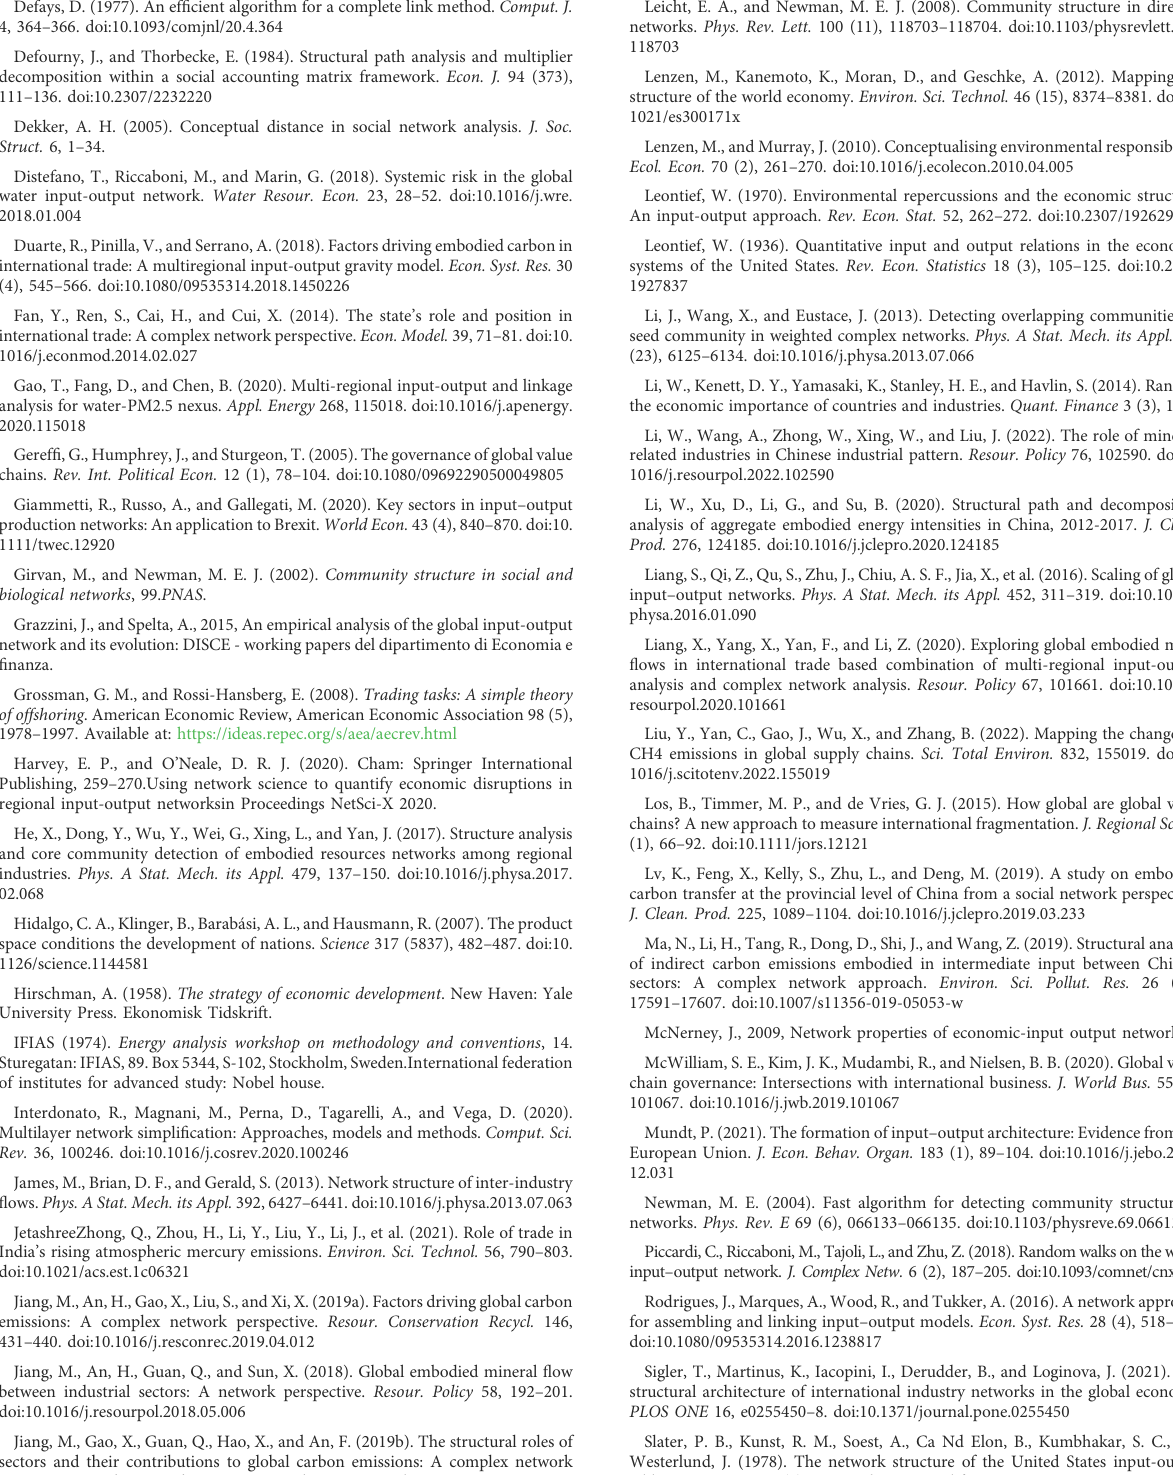
table. Empir. Econ. 3 (1), 49 – 70.